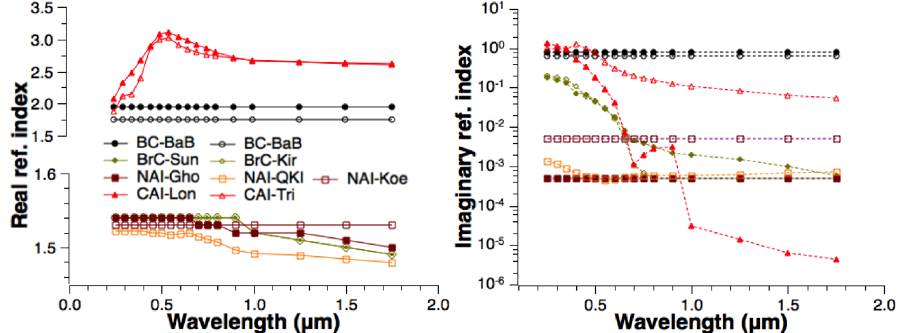
Figure 5. Complex refractive index of several aerosol species (BC, BrC, CAI, and NAI) in the host. The values with filled symbols are used in the presented size-dependent Maxwell Garnett conversion model. The values with open symbols are used to replace the corresponding values to test the uncertainties in the aerosol component retrievals. “BaB” represents Bond and Bergstrom (2006); “Sun” represents Sun et al. (2007); “Kir” represents Kirchstetter et al. (2004); “Gho” represents Ghosh (1999); “QKI” represents dust composed of a mixture of quartz (Ghosh, 1999), kaolinite (Sokolik and Toon, 1999), and illite (Sokolik and Toon, 1999), with the proportions of 48%, 26%, and 26%, respectively (Journet et al., 2014); “Koe” represents Koepke et al. (1997); “Lon” represents Longtin et al. (1988); and “Tri” represents Triaud (2005).